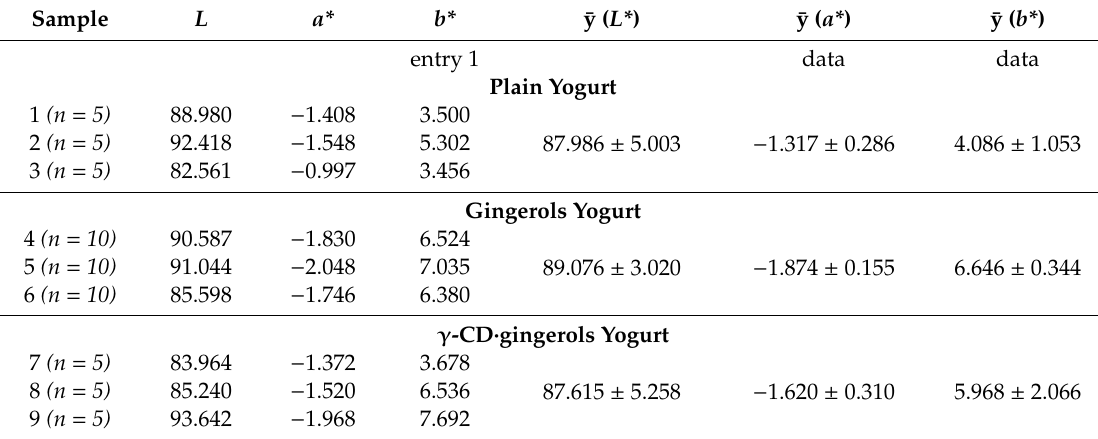
Table 3. Sample colour parameters, with mean (¯y) ± standard deviation for each